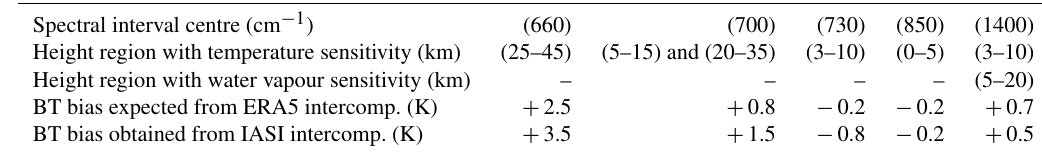
Table 2. BT biases expected from the comparison between profiles of the climate model and ERA5 and observed in the comparison of climate model simulations and IASI observed climatologies.